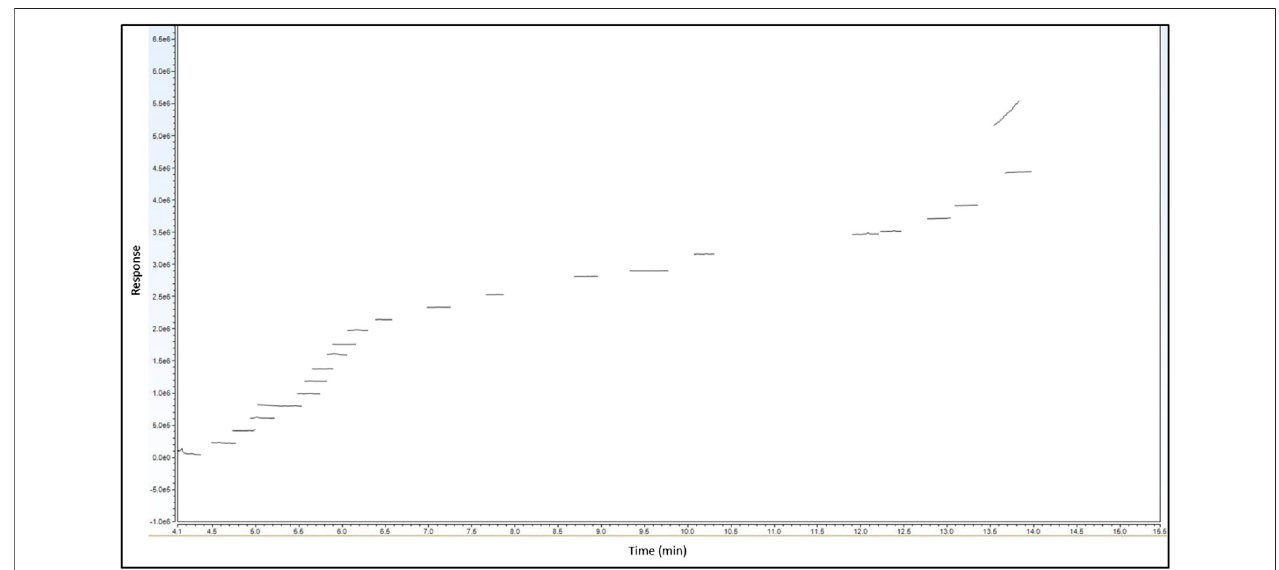
FIGURE 3 | Cleaned hops blank (LI-Syringe) demonstrating terpene-free surrogate matrix.